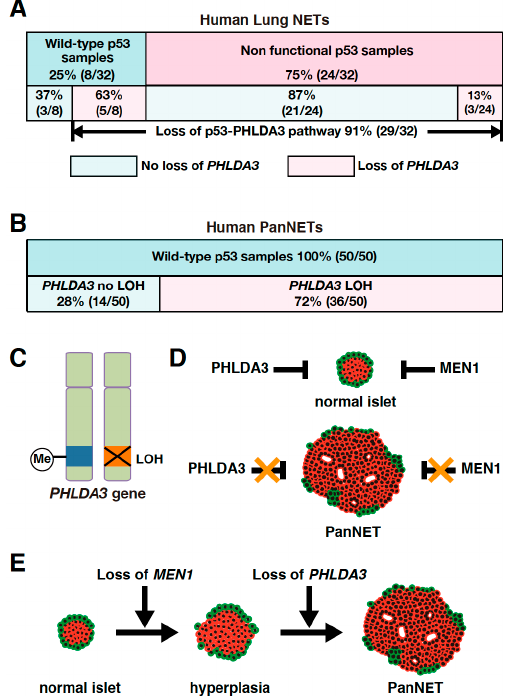
Figure 2. PHLDA3 gene defects are observed in lung and pancreatic neuroendocrine tumors